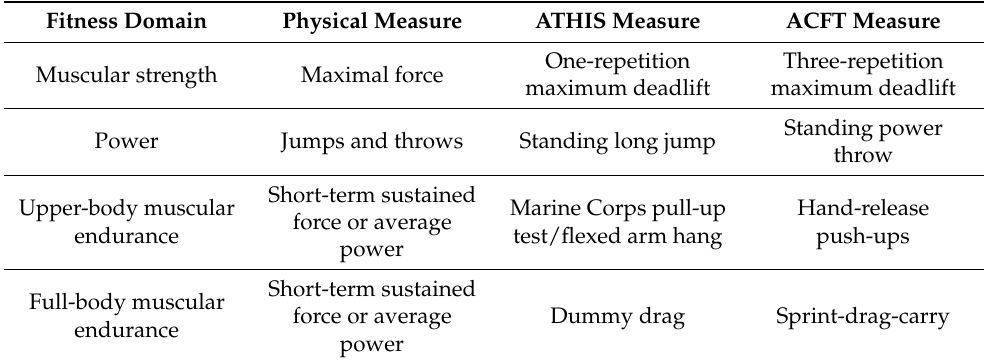
Table 1. Comparison of Army Training at High Intensity Study (ATHIS) measures to strength, power, and muscular endurance measures included in the Army Combat Fitness Test (ACFT). Fitness Domain Physical Measure ATHIS Measure ACFT Measure One-repetition Three-repetition Muscular strength Maximal force maximum deadlift maximum deadlift Standing power Power Jumps and throws Standing long jump throw Short-term sustained Upper-body muscular Marine Corps pull-up Hand-release force or average endurance test/flexed arm hang push-ups power Short-term sustained Full-body muscular force or average Dummy drag endurance power